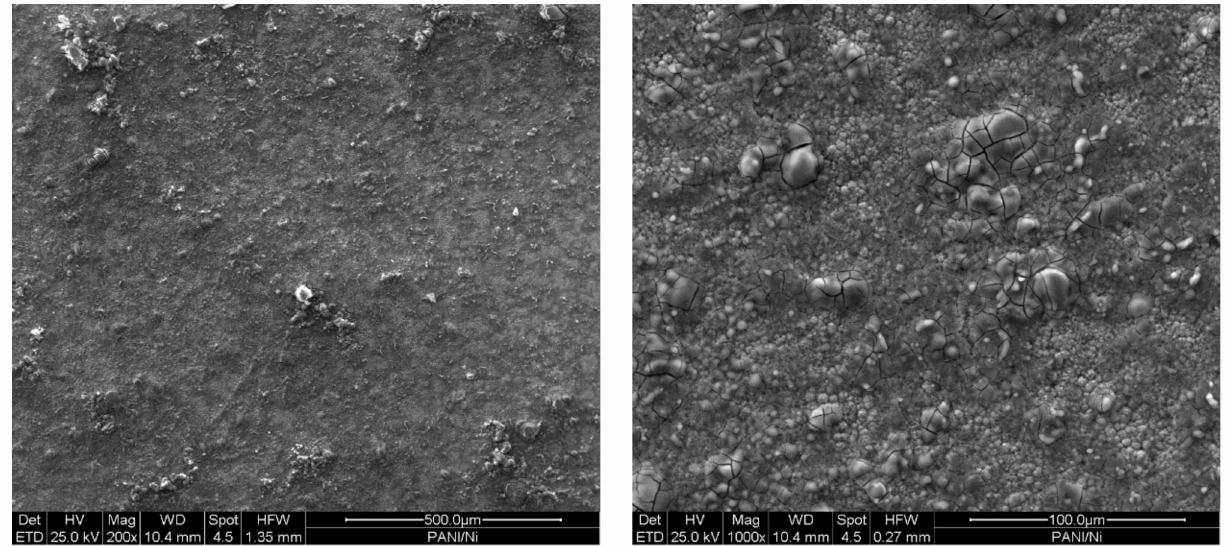
Figure 5. SEM micrographs (top view) of the layered Au|PANI|Ni